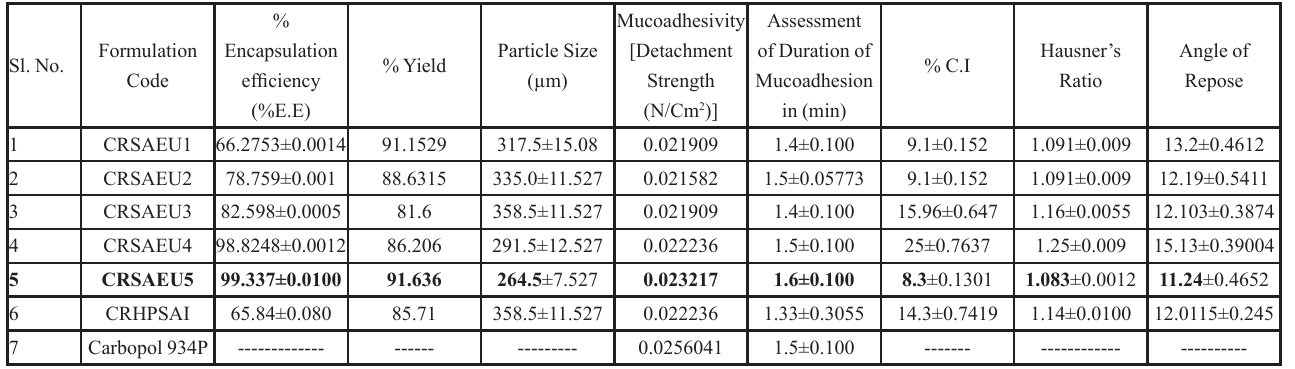
TABLE III - Micromeritic properties along with encapsulation efficiency, %yield and assessment of mucoadhesivity of formulations